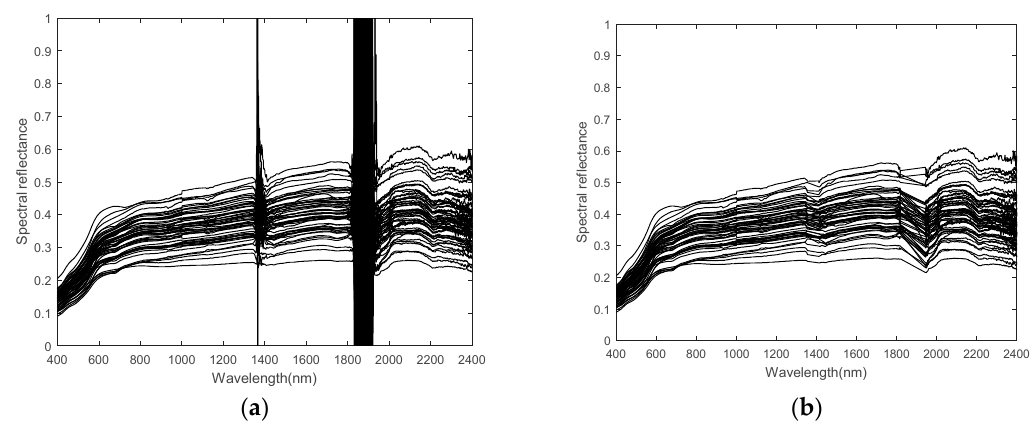
Figure 4. Spectrum curve s: ( a ) the entire band; ( b ) removing the moisture absorption segment.